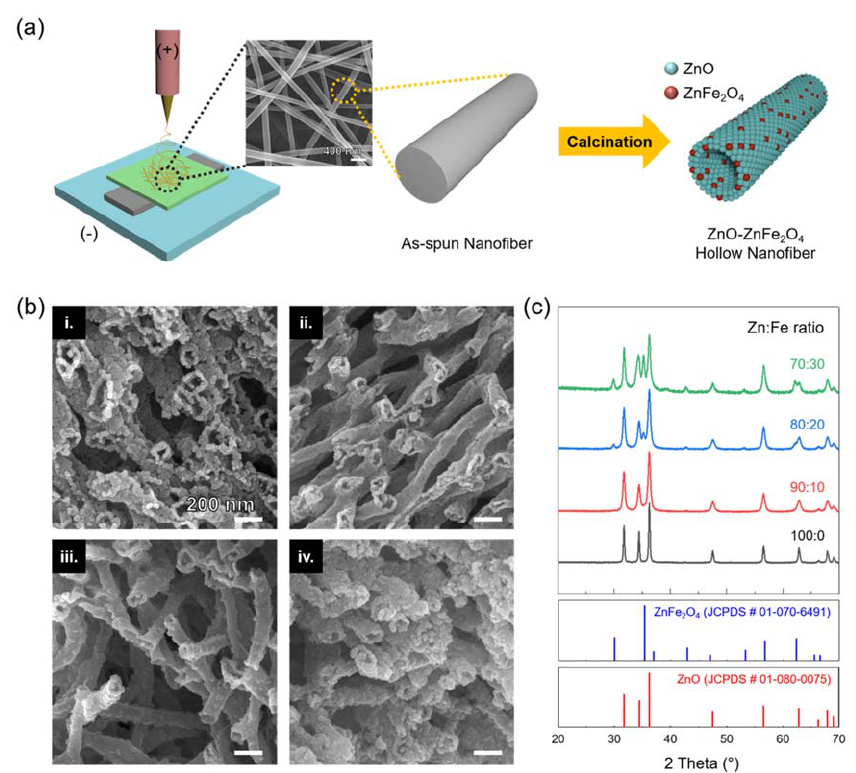
Figure 1. ( a ) Schematic process of the ZnO ‐ ZnFe 2 O 4 hollow nanofibers through one ‐ needle syringe electrospinning and the following calcination process. ( b ) FE ‐ SEM images of the ZnO ‐ ZnFe 2 O 4 hollow nanofibers of various compositions by controlling the precursor ratios of Zn and Fe for (i) 100:00, (ii) 90:10, (iii) 80:20, and (iv) 70:30. ( c ) XRD patterns of various ZnO ‐ ZnFe 2 O 4 hollow nano ‐ fibers.